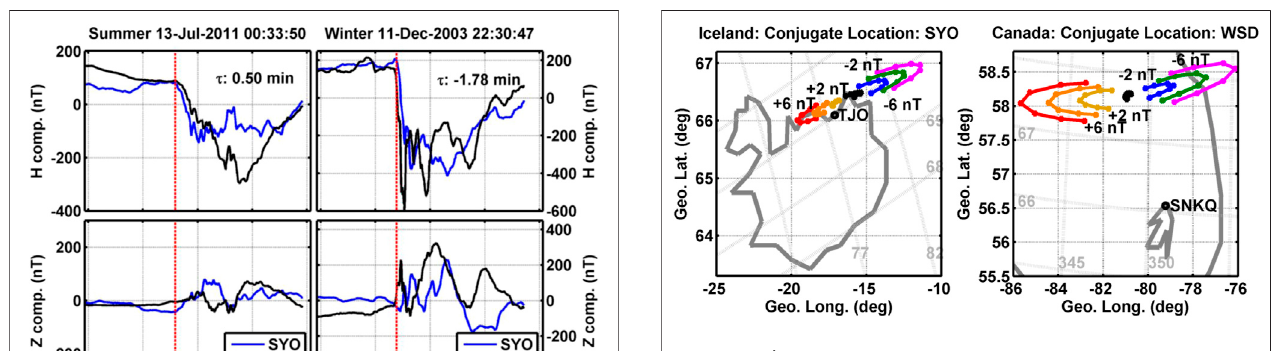
FIGURE 10 | Map of Iceland and Hudson bay Canada showing the location of the TJO and SNKQ stations, which are indicated with the circle, and the change in the location of the SYO and WSD conjugate foot point with IMF By from − 6 nT to +6 nT and dipole tilt for 3 h around local